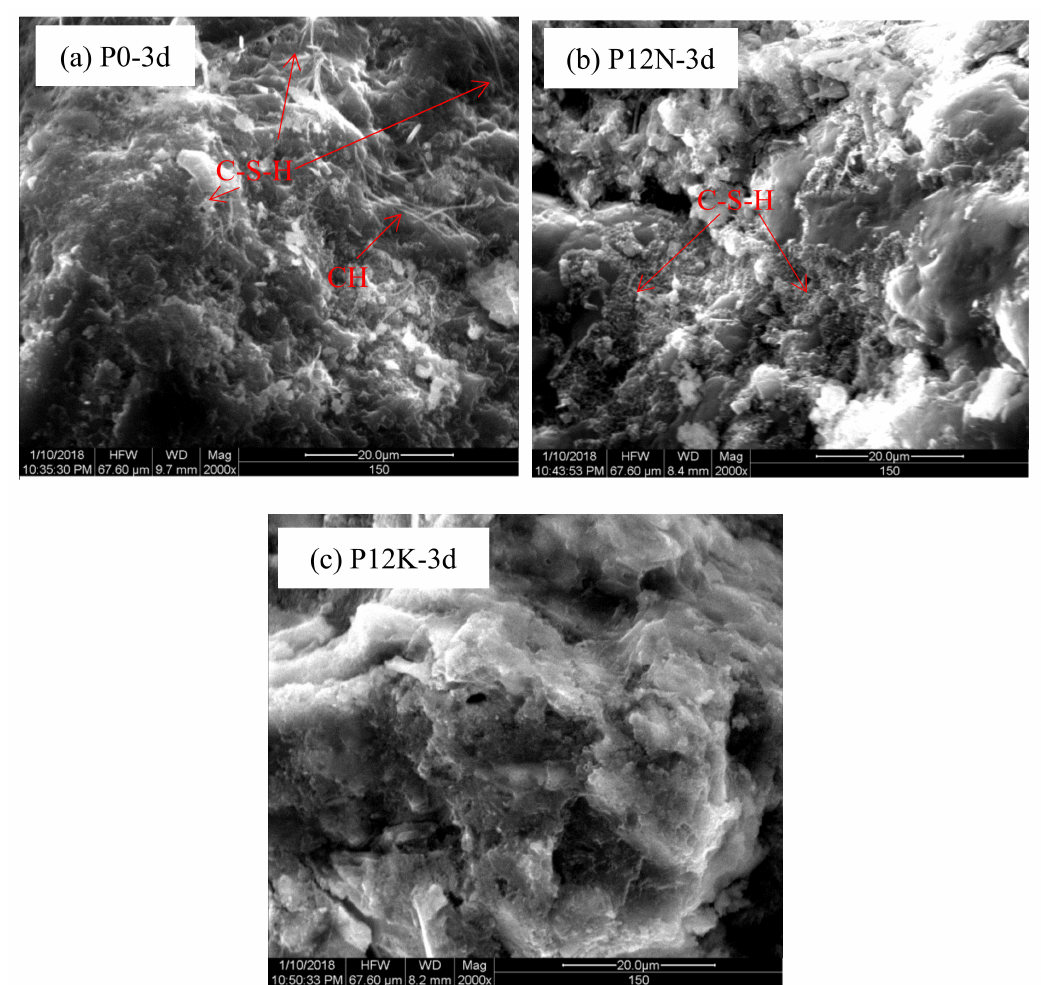
Figure 19. SEM map of OPC mortars with different contents and different types of alkali sulfates (2000 × ). ( a ) OPC pastes with alkali content of 0.4% at 3d; ( b ) OPC pastes with alkali content of 1.2% (added with Na 2 SO 4 ) at 3d; ( c ) OPC pastes with alkali content of 1.2% (added with K 2 SO 4 ) at